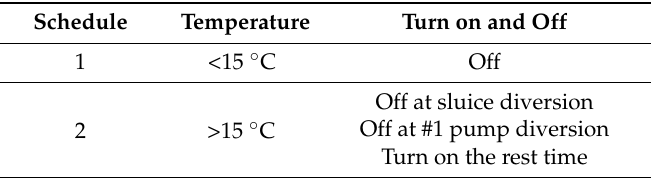
Table 5. Push pump turn on and off schedule.